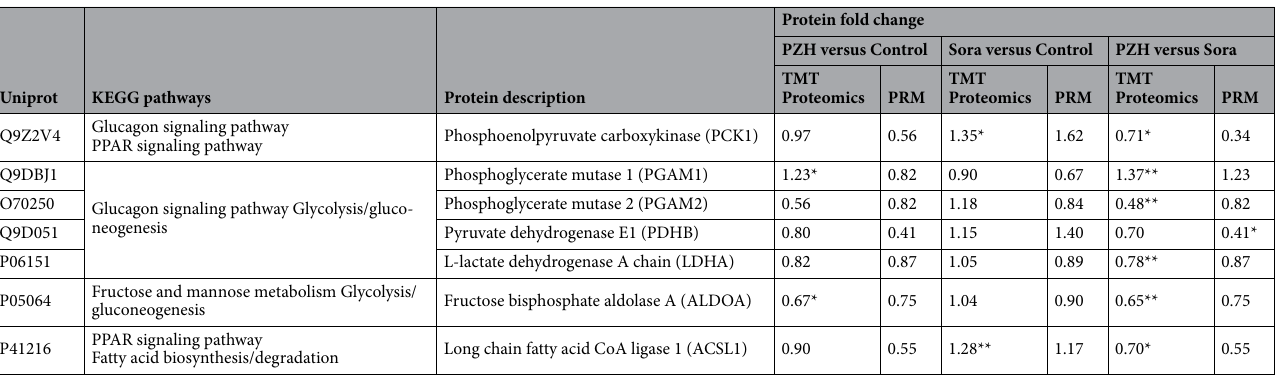
Table 2. Comparisons of differentially expressed proteins related to metabolic pathways treated with PZH and sorafenib from TMT proteomics and PRM verification. One-way ANOVA, * p < 0.05 versus control group, ** p < 0.01 versus control group. The value greater than 1 indicates up-regulation, less than 1 indicates down-